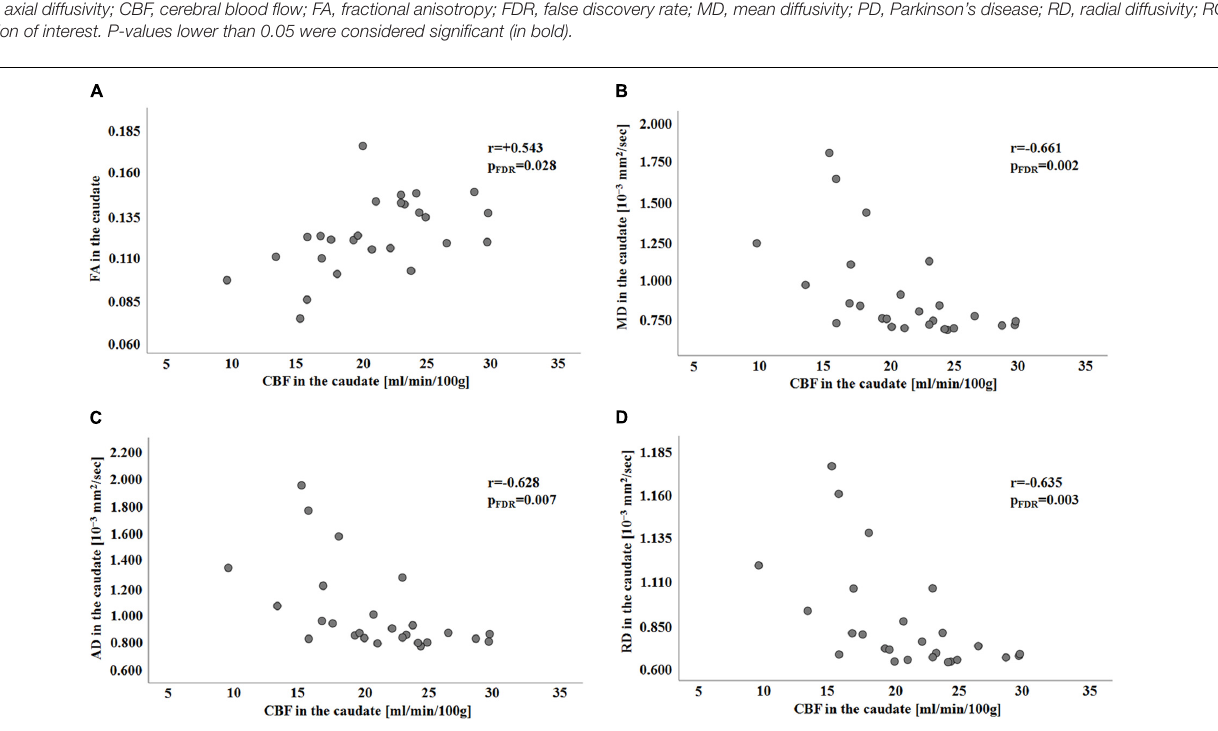
Frontiers in Aging Neuroscience |